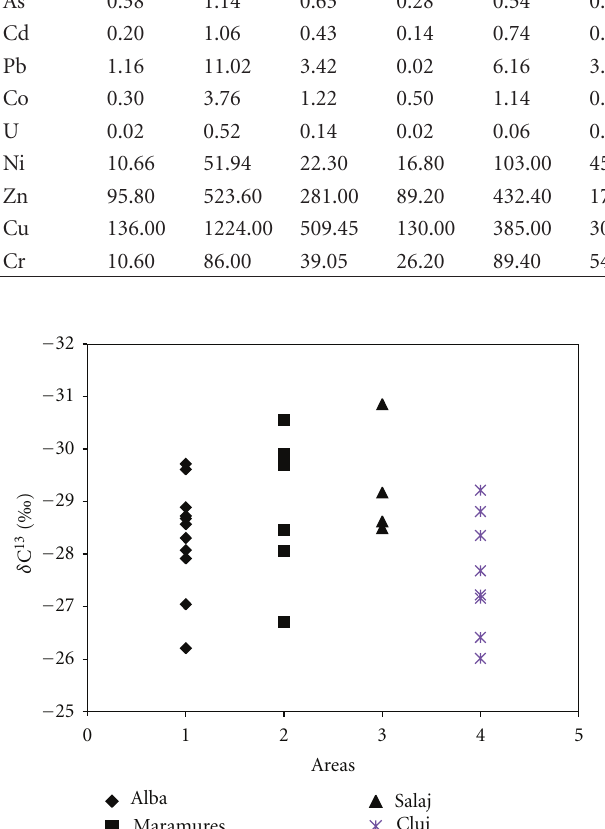
Figure 2: δ 13 C content of apples from investigated areas.